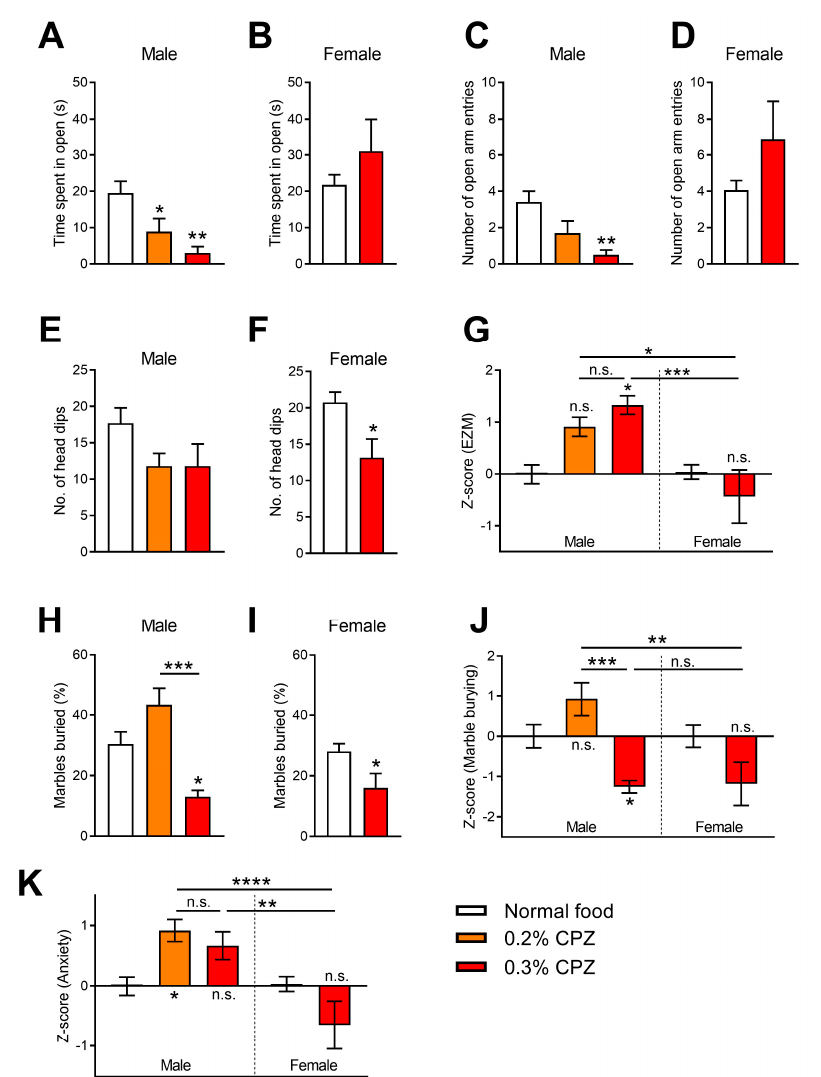
Figure 5. Administration of cuprizone has anxiogenic effects in male mice but not female mice. The elevated zero maze tested mice for 5 min with ( A , B ) time spent in the open arm, ( C , D ) the number of open arm entries and ( E , F ) the number of head dips measured for both sexes. Cuprizone in male mice exhibited a dose-dependent reduction in the number of open arm entries and a reduction in the time spent in the open arms. ( G ) Z-score analysis of all behaviours on the elevated zero maze (EZM) showed that only the male 0.3% cuprizone treatment group had an anxiogenic effect. ( H , I ) The marble burying test was used to measure anxiogenic and repetitive–compulsive behaviour in the mice. The 0.3% cuprizone dose reduced the number of marbles buried in both sexes. ( J ) Z-score analysis of the marble burying behaviour confirmed there was no sex difference between the 0.3% cuprizone dose. ( K ) Z-score analysis of the elevated zero maze and marble burying data combined showed an increase in anxiety-like behaviours in male mice treated with cuprizone compared to female mice. Unpaired t-tests for female comparisons and one-way ANOVA with Bonferroni post-tests for the male and z-score comparisons. * p < 0.05, ** p < 0.01, *** p < 0.001, **** p < 0.0001. n.s. = not significant. Data presented as mean ± SEM. n =